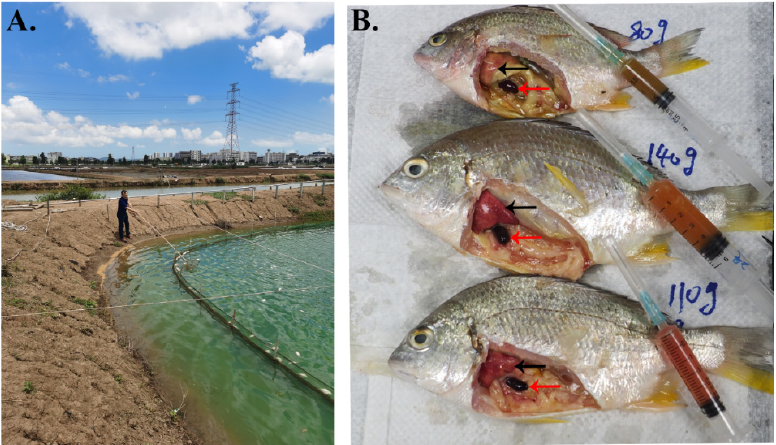
Figure 1. A recent mortality event of YFSBAD and the clinical symptoms of naturally infected large ‐ sized yellowfin seabream (80~140 g per fish). ( A ) A recent outbreak of YFSBAD in a local farm in Zhuhai. ( B ) The diseased fish were characterized by swollen abdomens, ascites, splenomegaly, and petechial to ecchymotic hemorrhage in the liver. Over 2 mL of ascites were extracted from each fish. The red arrows indicate enlarged spleens. The black arrows indicate bloodless liver.